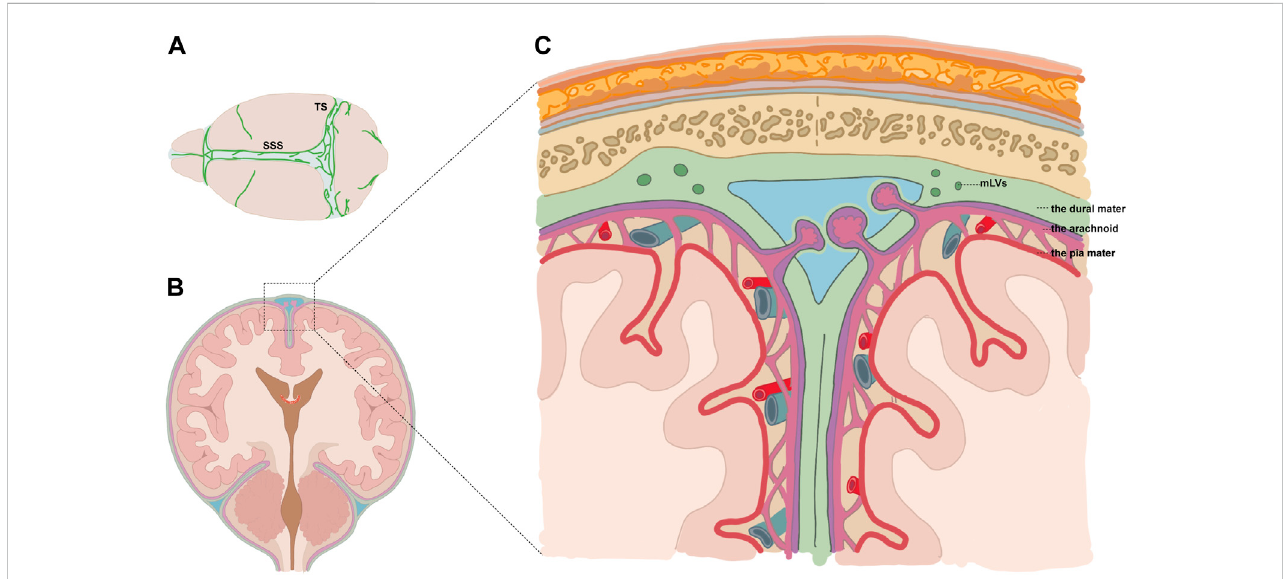
FIGURE 1 Diagram showingthelocationof mLVs. (A) Meningeallymphaticvessels(mLVs) locatedaround thesuperiorsagittal sinus (SSS), transversesinus (TS), etc. (B,C) Vessels were located within dural folds (green) and were adjacent to the subarachnoid